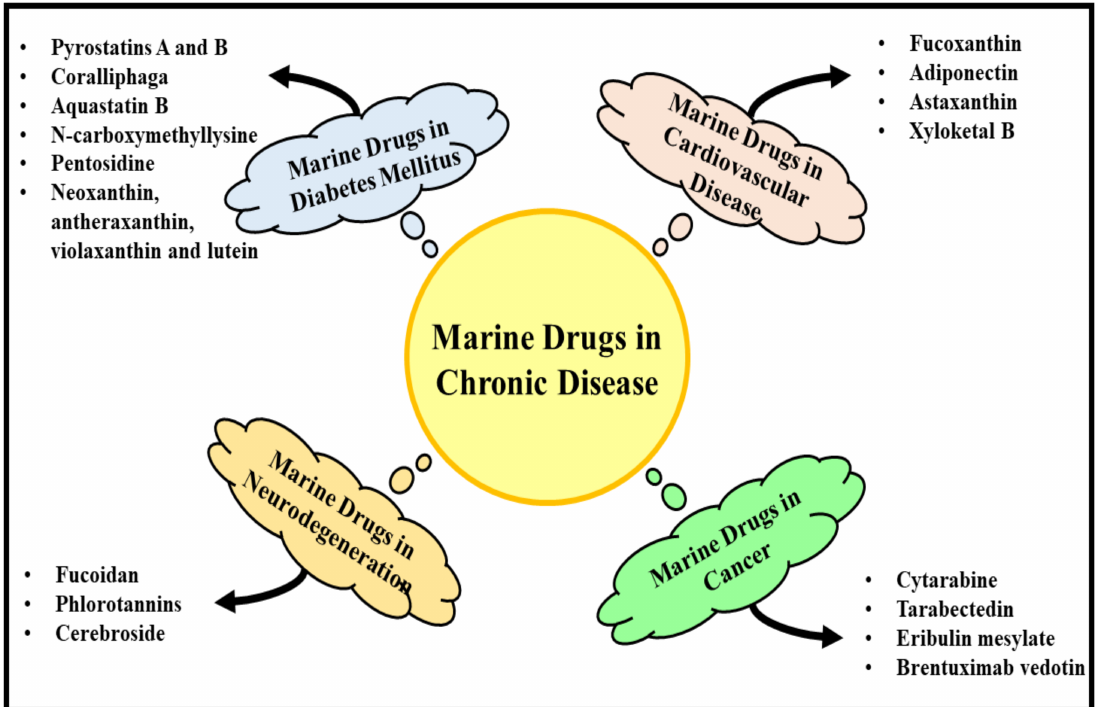
Figure 2. This figure provides a descriptive overview of the marine drugs used in diabetes mellitus, cancer, neurodegenerative disease, and cardiovascular